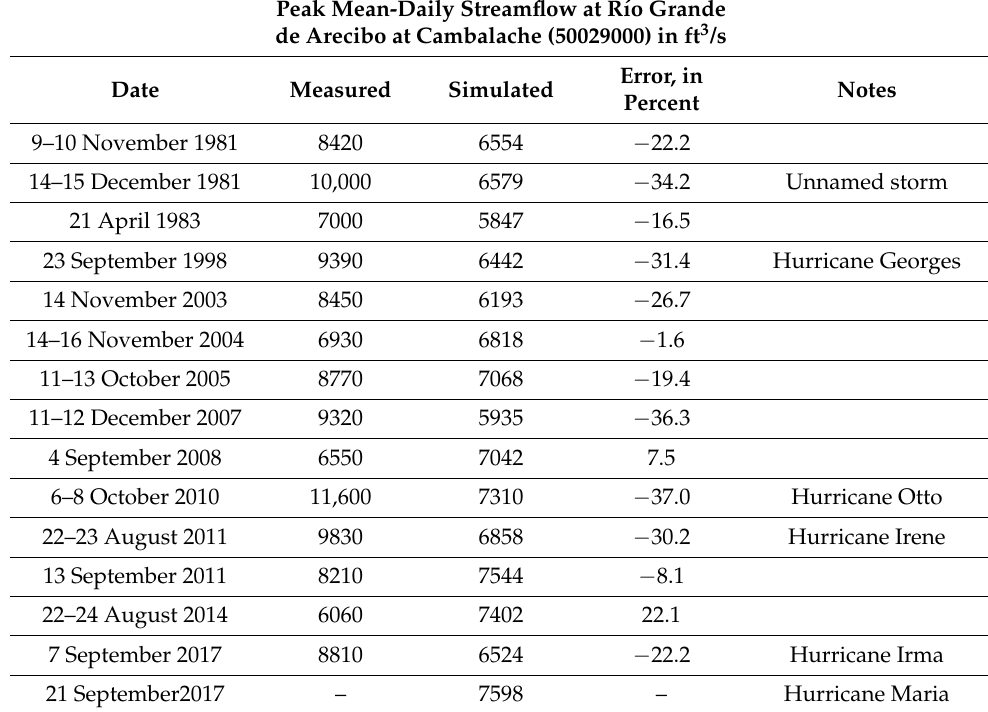
Table 8. Peak measured streamflows over 6000 cfs during period of simulation. Peak Mean-Daily Streamflow at R í o Grande de Arecibo at Cambalache (50029000) in ft 3